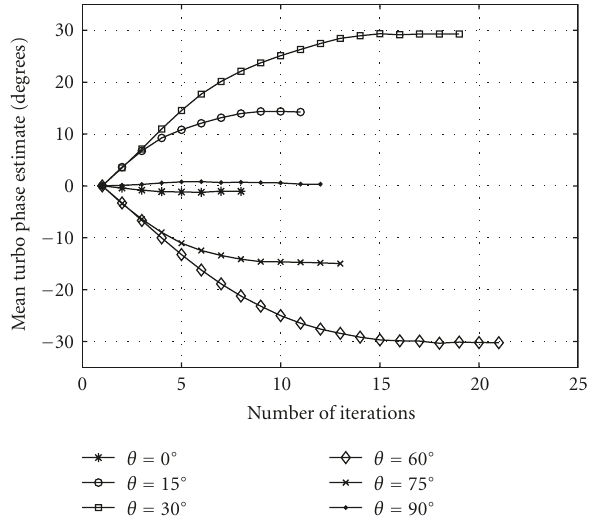
Figure 4: Evolution of turbo phase estimates over sub-blocks during